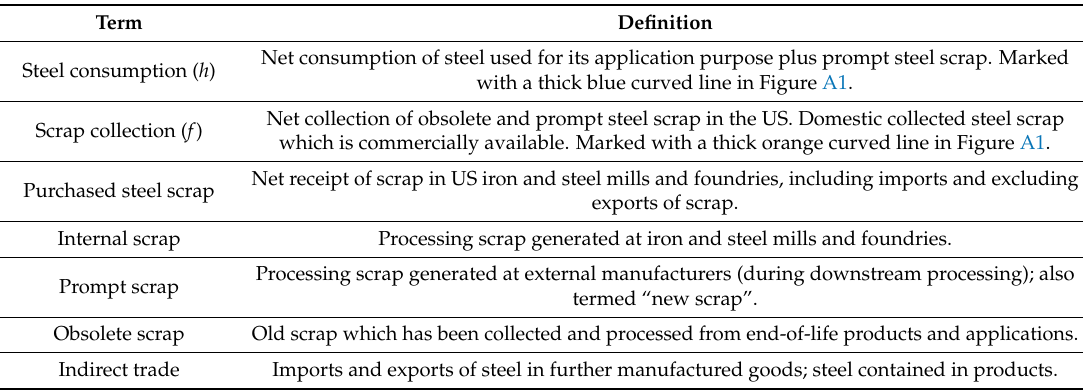
Figure A1. Material flow of steel in society, showing the extent of the system considered in this study and the model input data. Table A6. Nomenclature on stocks and flows, with